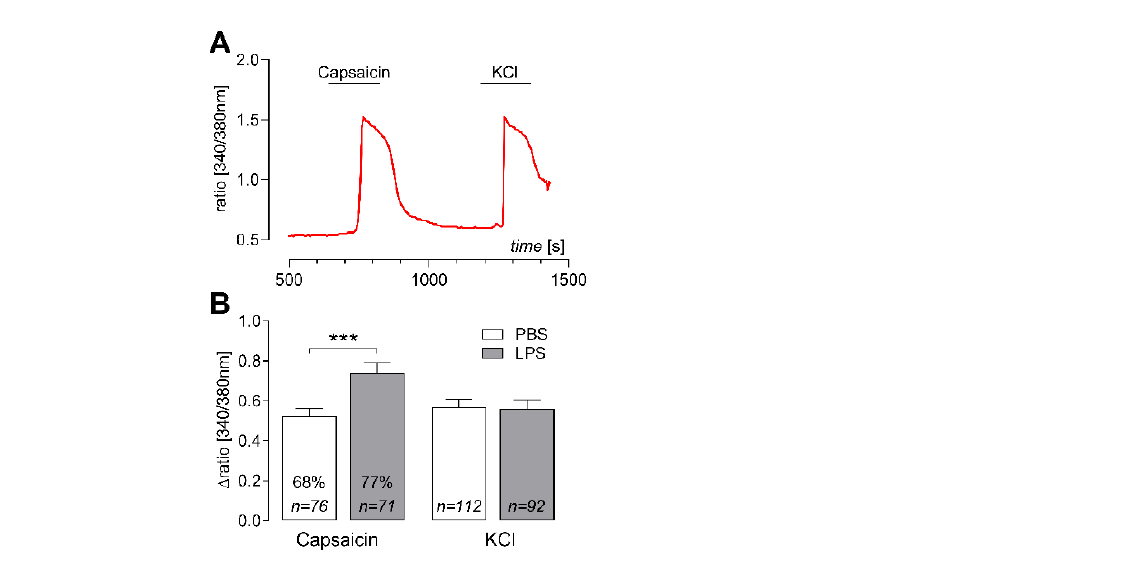
Figure 3. Elevated calcium responses of cultured dorsal root ganglia (DRG) neurons after LPS challenge (ex vivo). Primary cultures of DRG were obtained from PBS- and LPS-treated rats and used for Ca 2+ imaging experiments. Capsaicin, a TRPV1 agonist and KCl were applied as excitatory stimuli leading to distinct Ca 2+ responses ( A ). Stimulus-induced increases from baseline were calculated as ∆ ratio [340/380 nm] ( B ). Capsaicin-responses were significantly higher in cultured DRG neurons from LPS-treated rats compared to PBS-treated controls; 68% (PBS, n = 76 ) or 77% (LPS, n = 71) of all investigated neurons were responsive to capsaicin-stimulation. No treatment effects were detectable for KCl-responses. Bars represent the mean ± SEM. ***: p < 0.001. PBS: phosphate buffered saline, LPS: lipopolysaccharide.